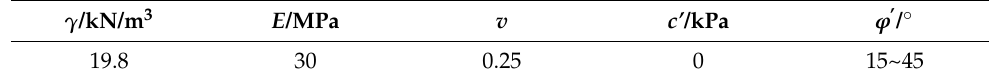
Table 1. Parameters for numerical